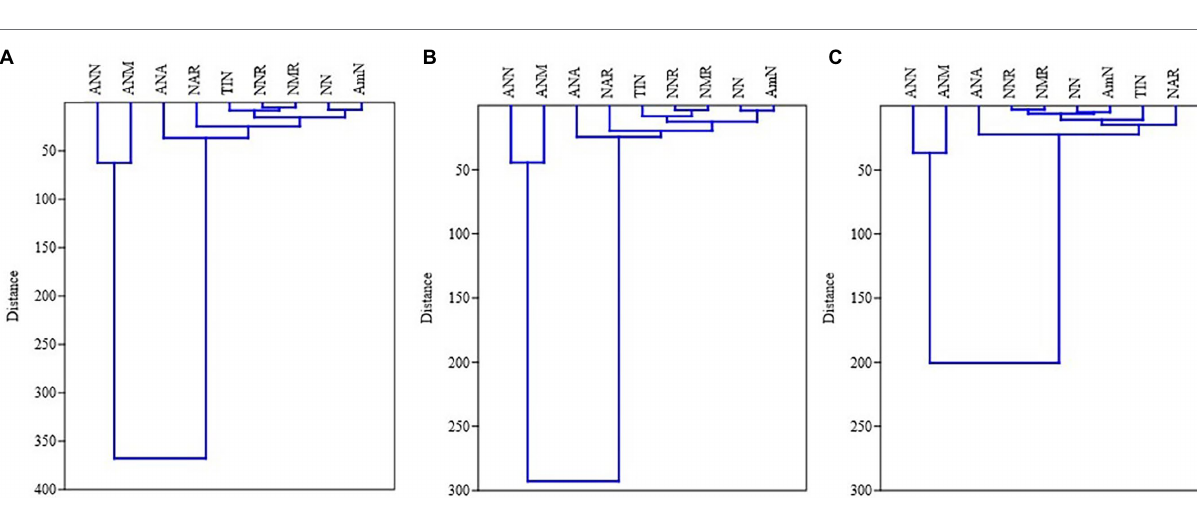
FIGURE 3 | Correlation analysis – dendrograms showing hierarchical clustering of N variables in (A) LA: litter addition, (B) LC, litter control, and (C) LC: litter removal treatments across both forest types [MPPF and (B) MCMF stand]. AmN: NH 4+ -N, NN: NO 3 − -N, TIN, total inorganic nitrogen; NAR, net ammonium rate; NNR, net nitrification rate; NMR, net mineralization rate; ANA, annual NH 4+ -N production; ANN, annual NO 3 − -N production; ANM, annual total inorganic